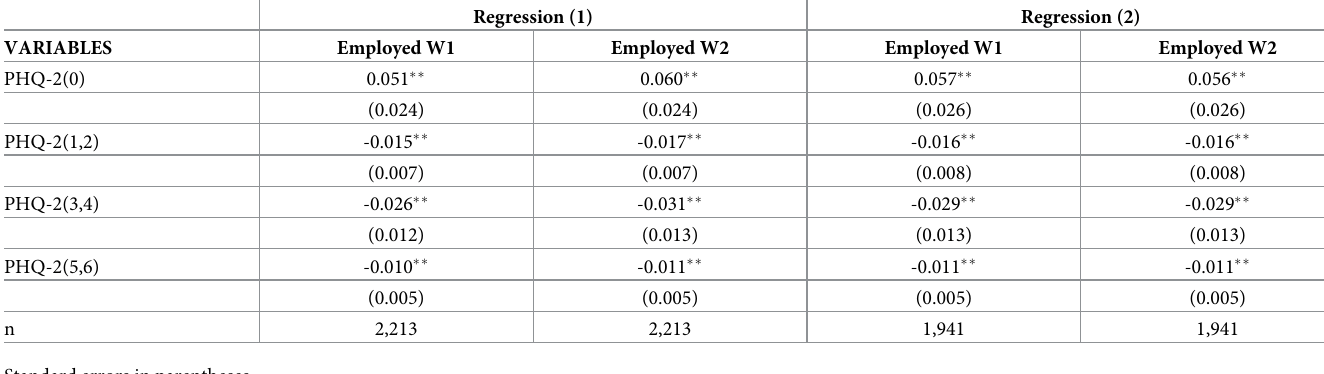
Table 3. Marginal effects (Regressions 1 and